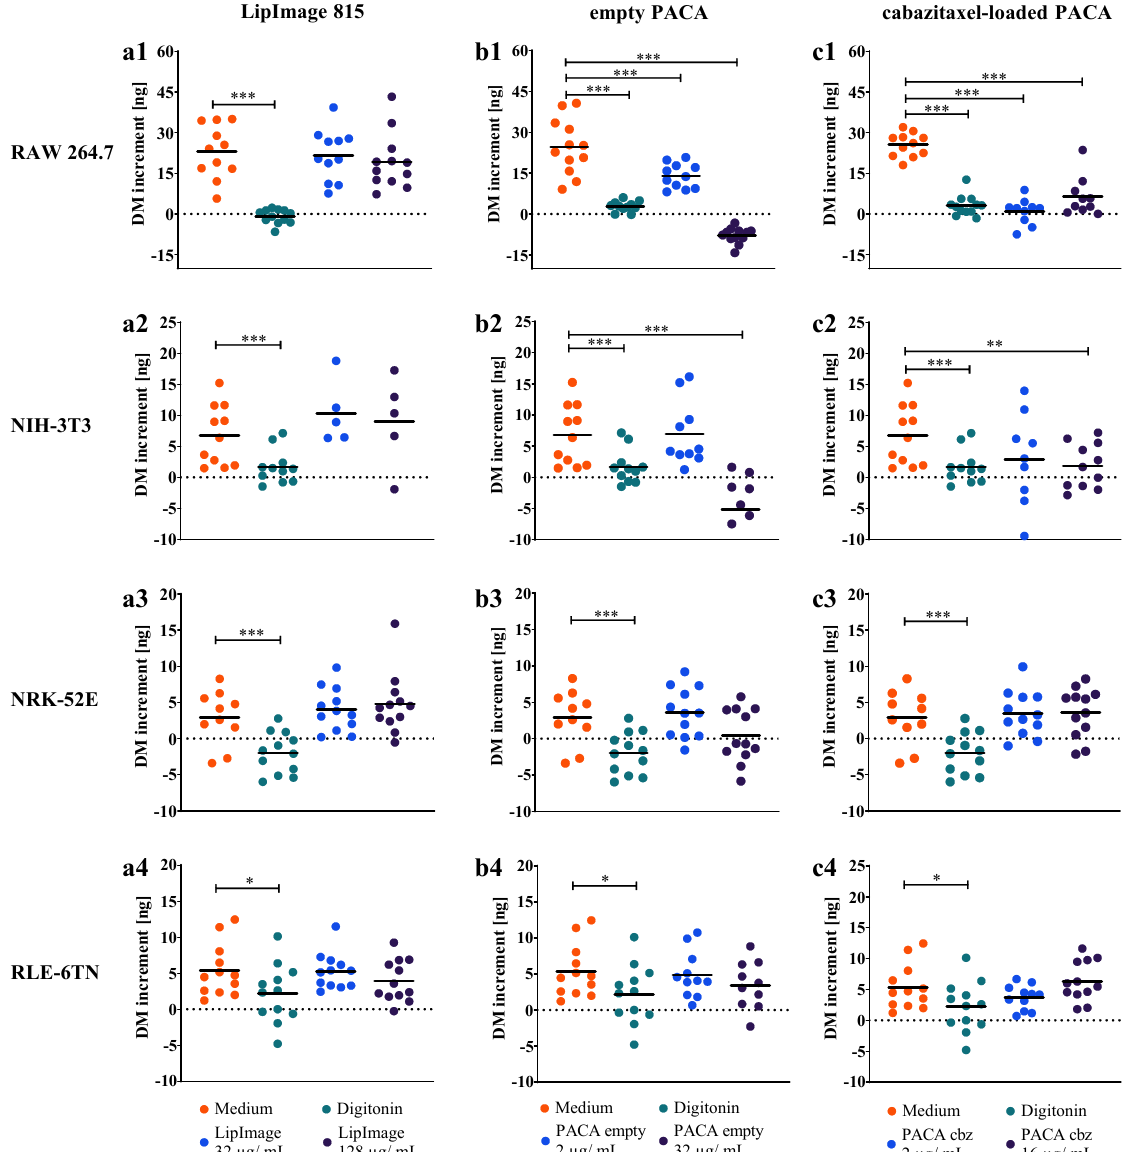
Figure 5. Increment of the cell population dry mass (DM) in the FOV after 24 h of incubation with cell culture medium, digitonin, and nanoparticles. Data points represent the dry mass increment of the cell populations within a single FOV. Data were acquired from different sample areas in 12 FOVs during N = 3 independent experiments. LipImage™ 815 lipidots® nanoparticles, ( a1 – a4 ), empty PACA nanoparticles ( b1 – b4 ), and cabazitaxel-loaded PACA nanoparticles ( c1 – c4 ) were tested on RAW 264.7, NIH-3T3, NRK-52E, and RLE-6TN cells. Each experiment included a set of corresponding controls: cell viability medium control and cytotoxicity control digitonin. Significance levels: p < 0.005(***), p < 0.01(**), p <